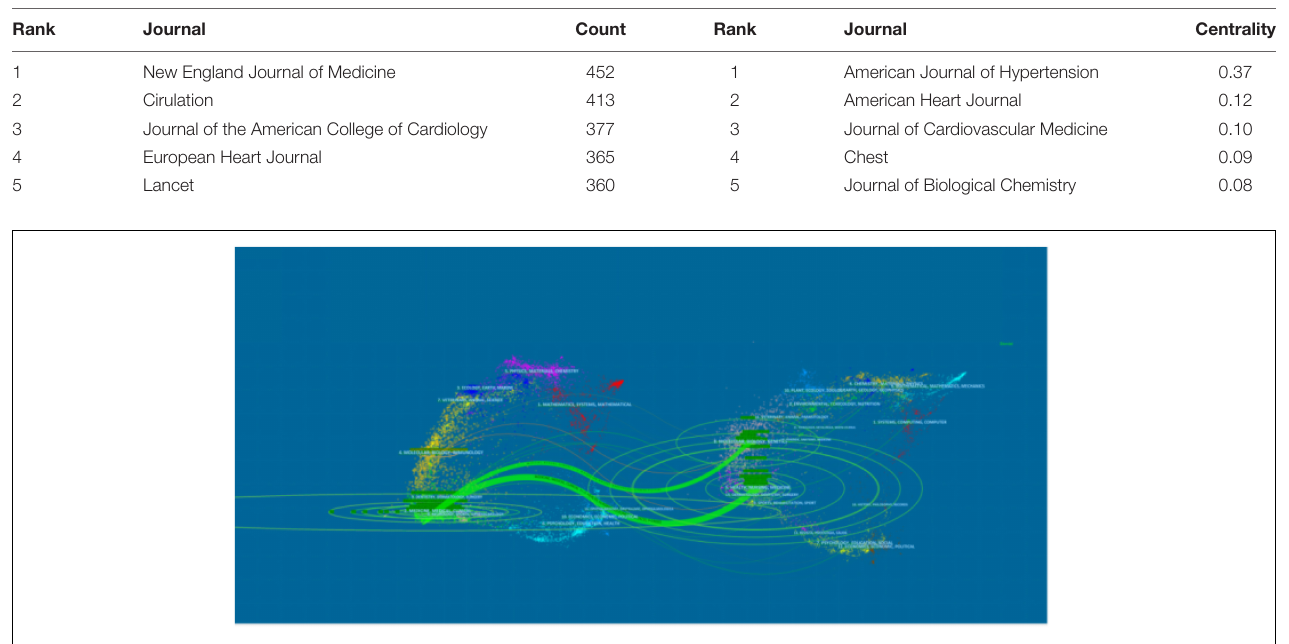
FIGURE 6 | The dual-map overlay of citations of articles on the application of ARNI in the cardiovascular field (The left side were the citing journal, the right side were the cited journal, and the line path represents the citation